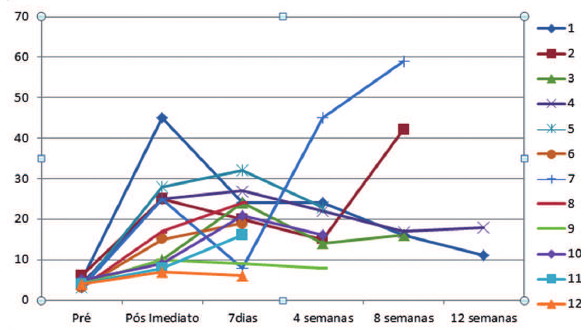
Fig. 5. Evolução do gradiente (em mmHg) através da prótese ao longo do